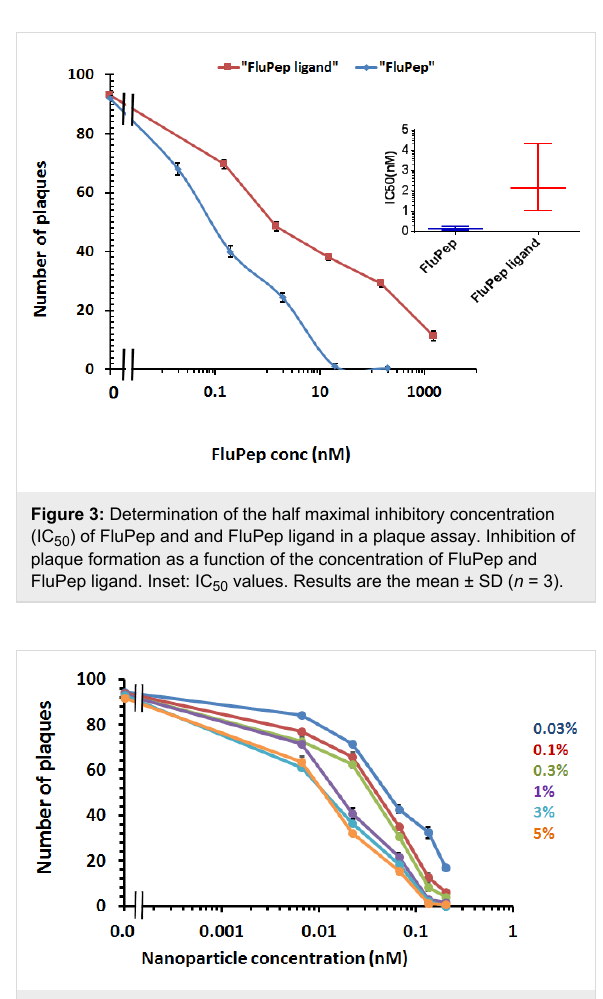
Figure 4: Effect of gold nanoparticles functionalised with FluPep ligand on influenza virus plaque formation. Inhibition of plaque formation as a function of the concentration of gold nanoparticles functionalised with different molar fractions of FluPep ligand in the ligand mixture. Results and the mean ± SD ( n =